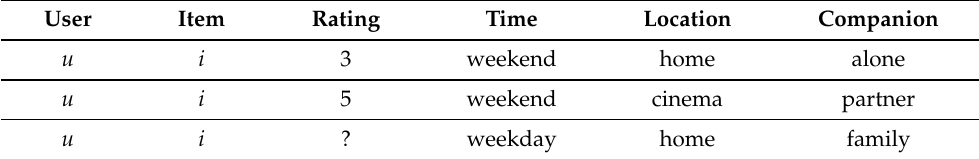
Table 2. Contextual Ratings on Movies.